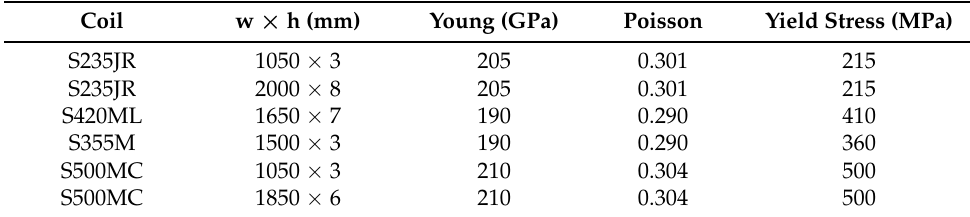
Table 1. Steel coils used for collecting real data and their specifications.